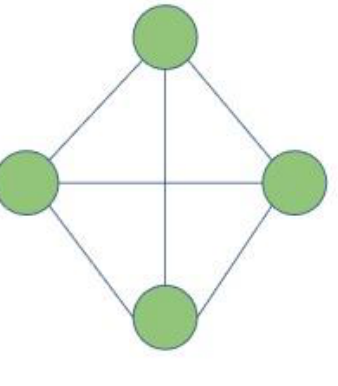
Figure 6. Visual representation of committee